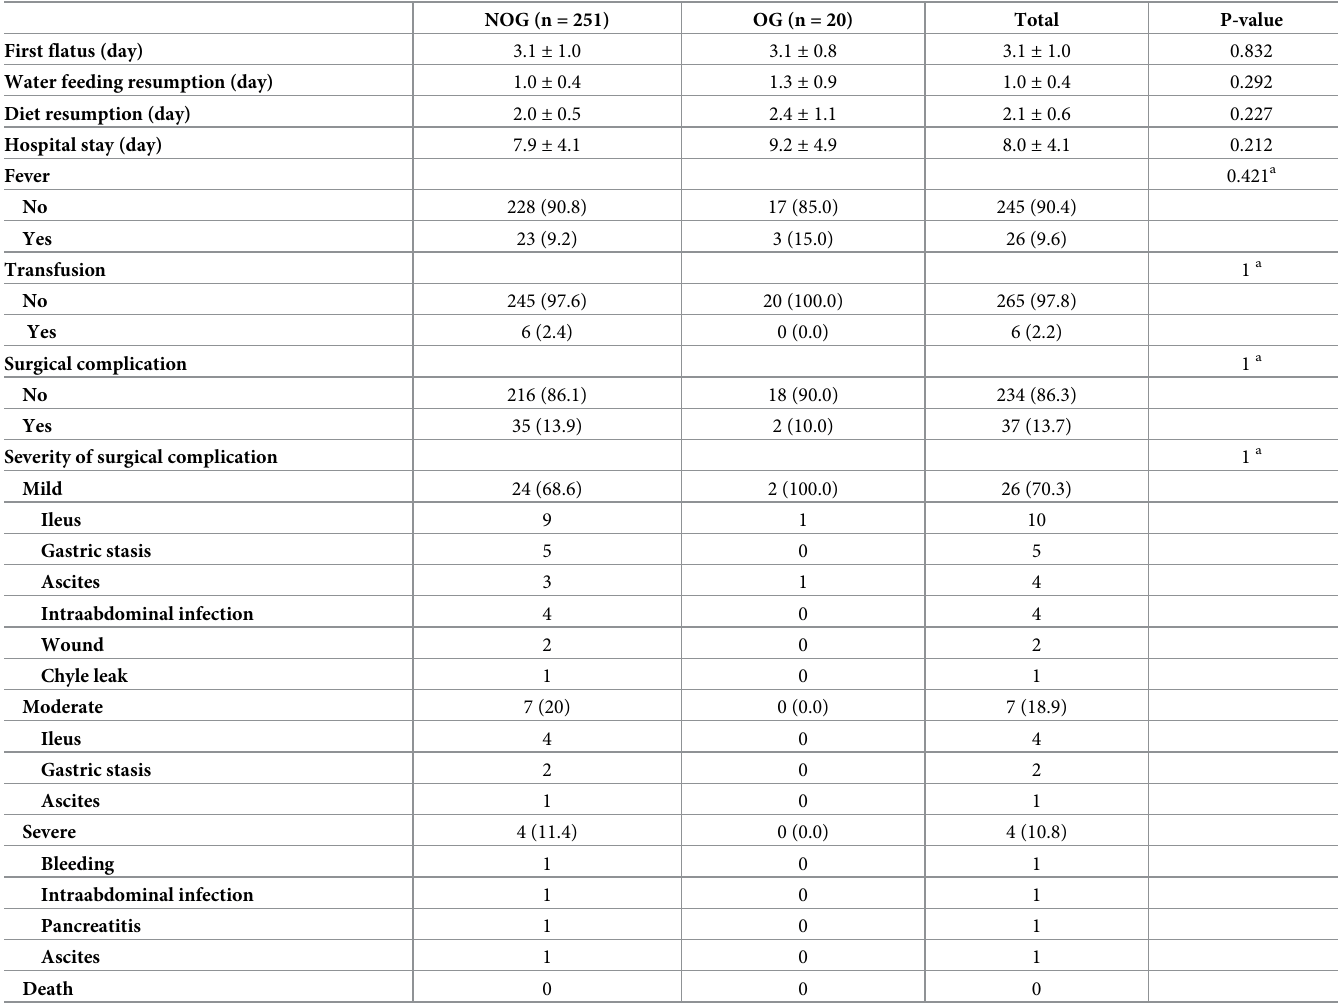
Table 4. Postoperative